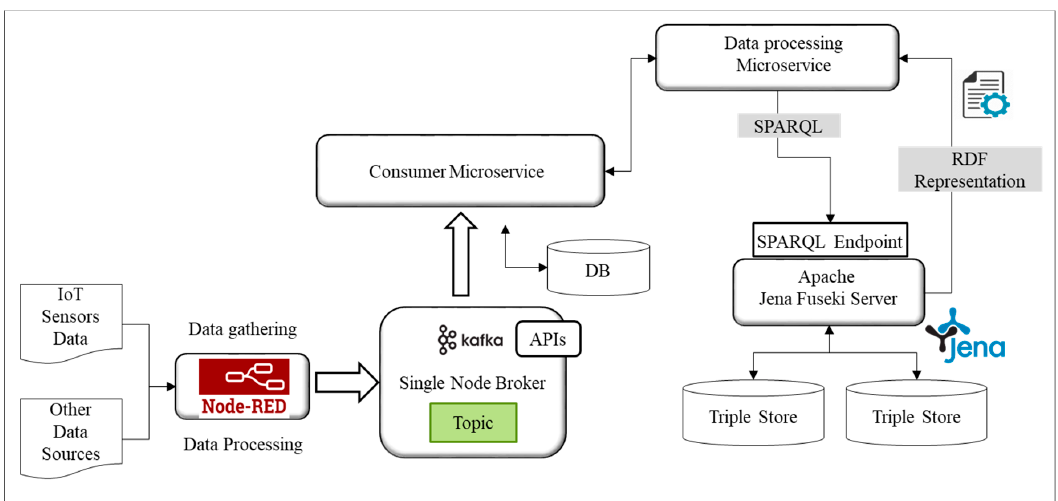
Figure 13. Data collection and semantic processing implementation diagram.